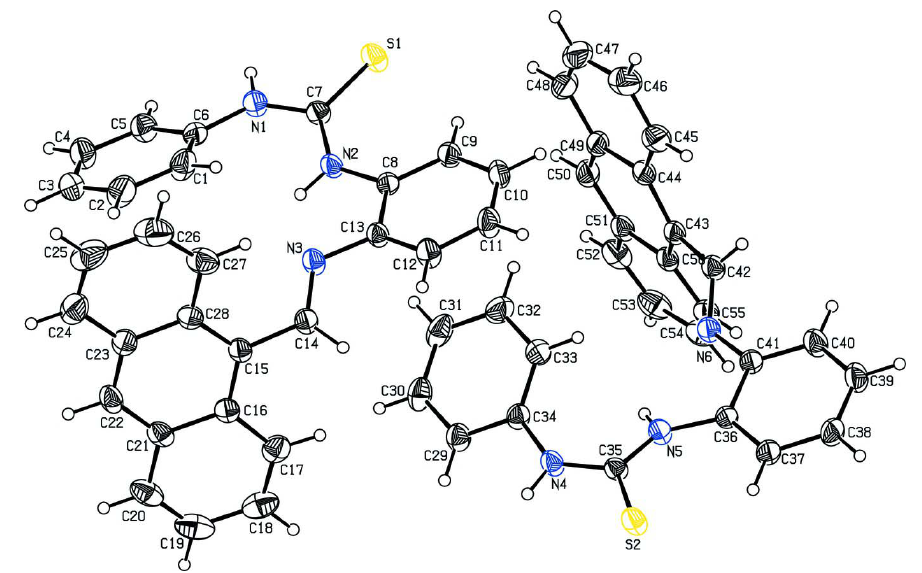
Figure 1 The molecular structure of title compound, showing 30% probability displacement